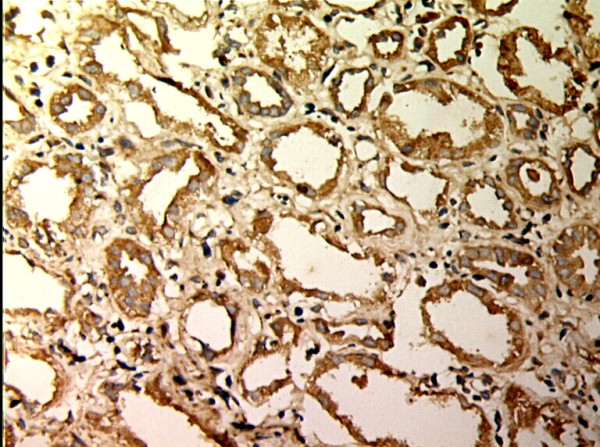
MMP-2 expression in renal tissue with different degree of inflammatory infiltration(EnVision assay; original magnification × 200). IF/TA-II Group.